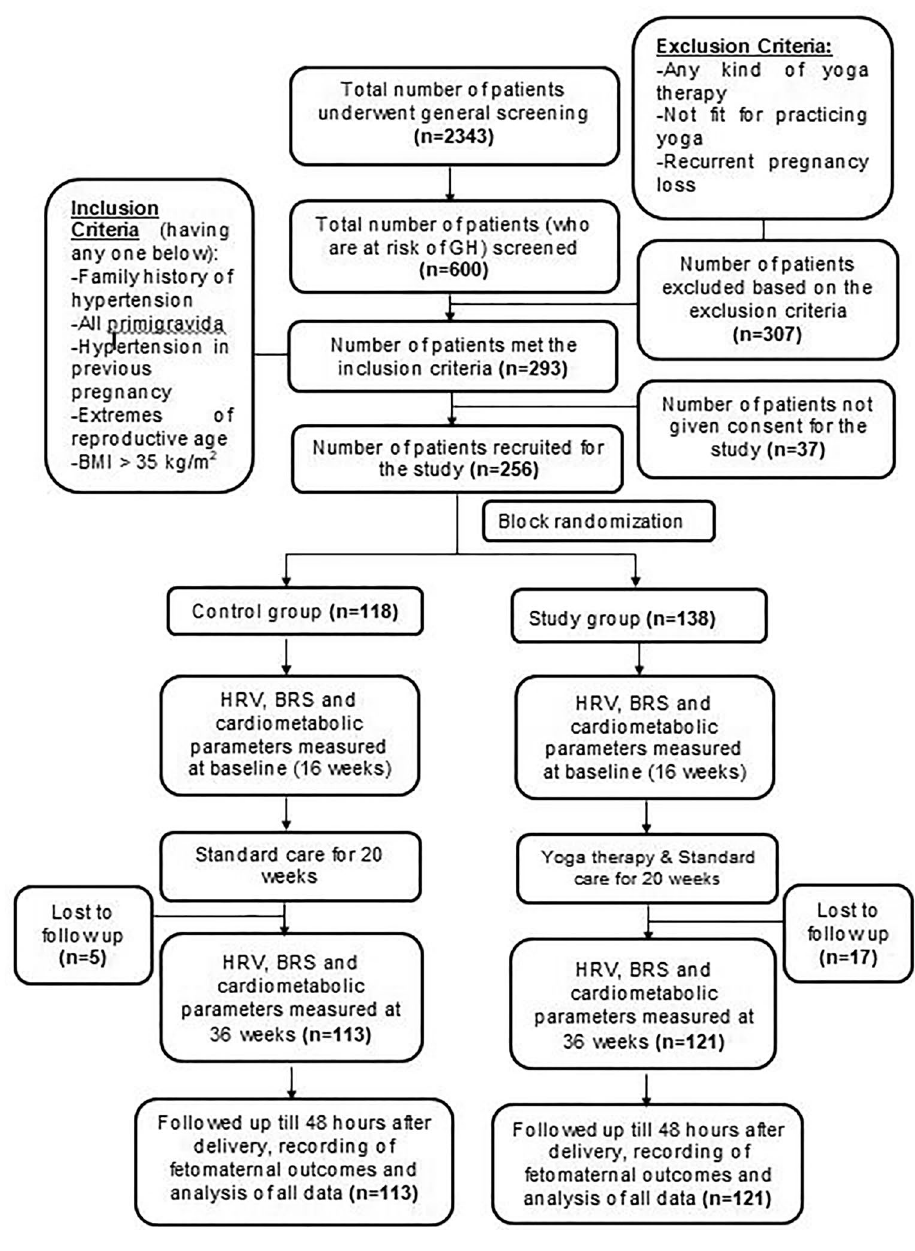
Figure 1. RCT consort